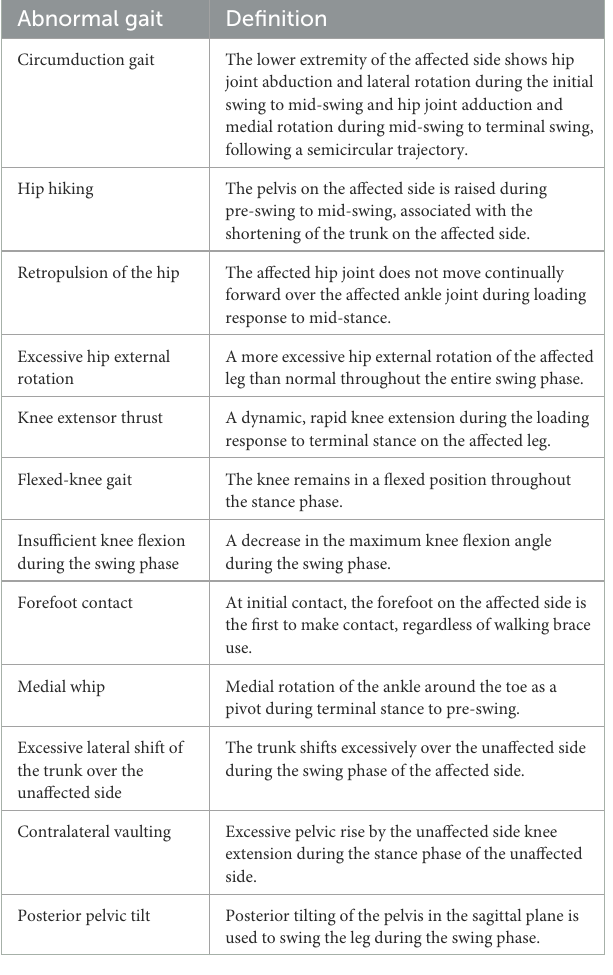
TABLE 2 Participant characteristics ( n = 23).